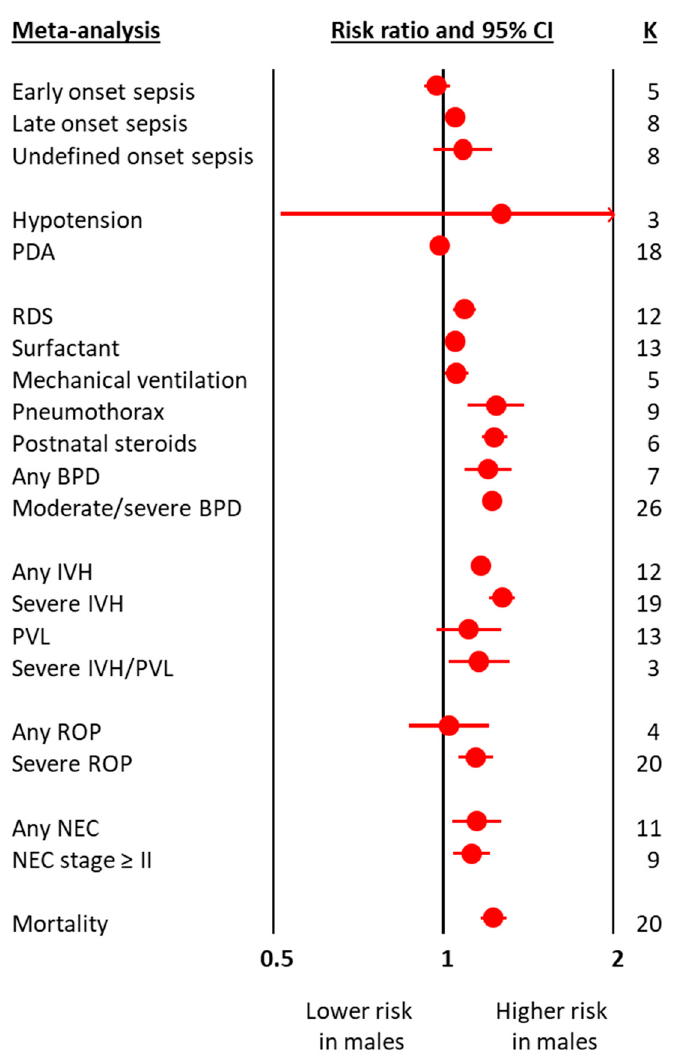
Figure 2. Summary of meta-analyses on the association between clinical characteristics and outcomes of preterm infants and male sex. BPD: bronchopulmonary dysplasia; CI: confidence interval; IVH: intraventricular hemorrhage; K: number of studies; NEC: necrotizing enterocolitis; PDA: patent ductus arteriosus; PVL: periventricular leukomalacia; ROP: retinopathy of prematurity. Table 2. Meta-analyses on the association between clinical characteristics and outcomes of preterm infants and male sex. 95% CI Heterogeneity p Meta-Analysis K RR Lower Upper I 2 (%) Limit Limit